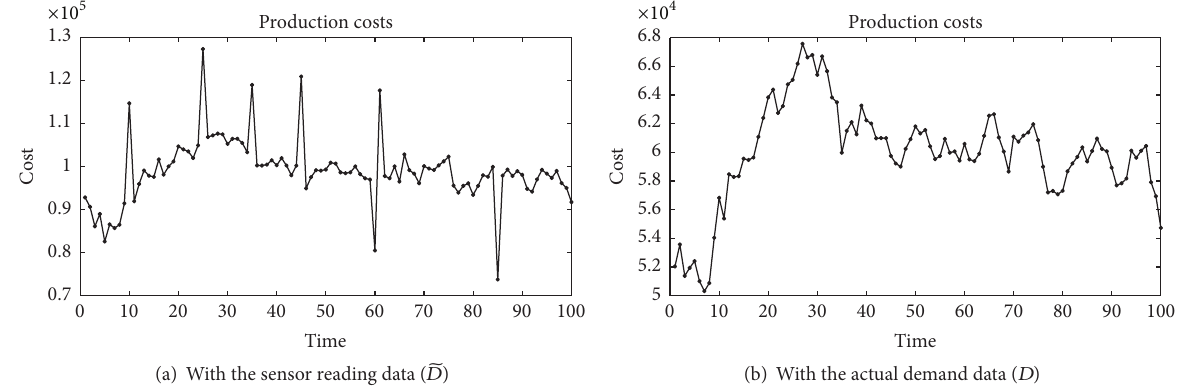
Figure 6: Cost function output through optimization